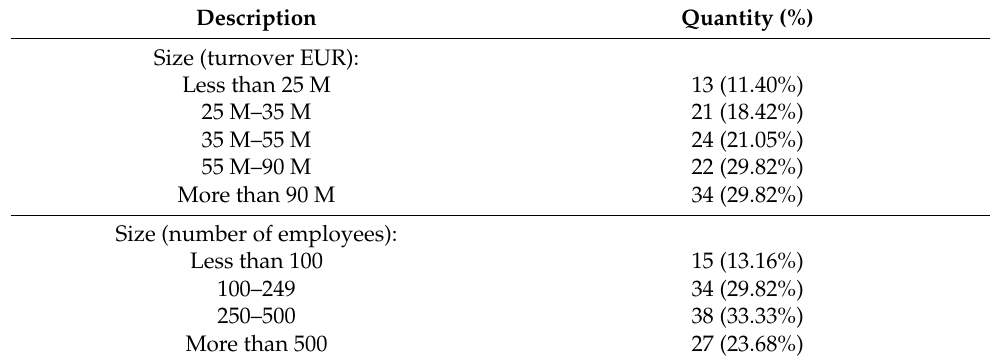
Table 1. Characteristics of sample and